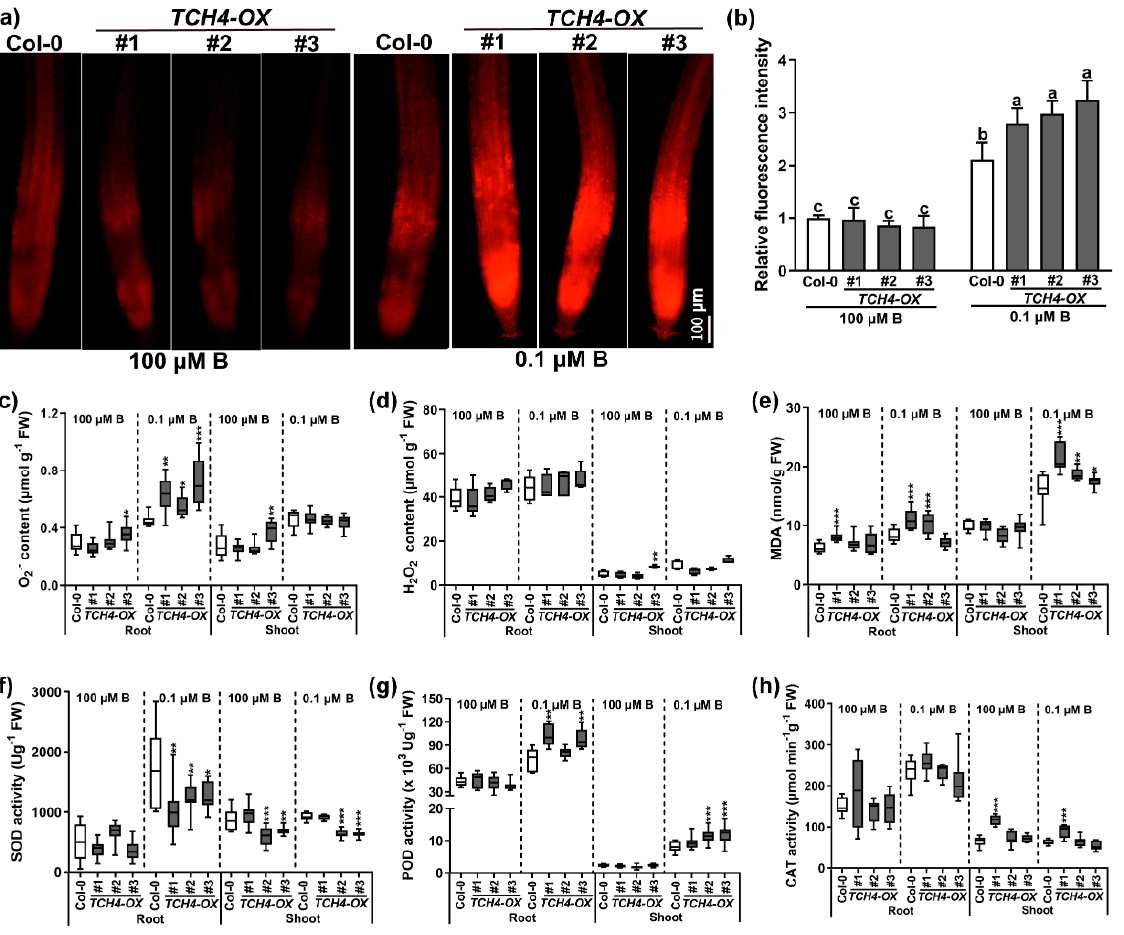
Figure 9. Differences in O 2 − , H 2 O 2 , and MDA content and antioxidant enzyme activities in Col-0 and TCH4-OX plants. The plants were grown in media consisting of 100 and 0.1 μ M B conditions for 10 d. ( a ) DHE staining. Scale bar, 100 μ m. ( b ) Relative fluorescence intensity was measured (means ± s.d., n = 7). The different letters above the columns indicate significant differences between all genotypes and all growth conditions ( p ≤ 0.05). ( c ) O 2 − , ( d ) H 2 O 2 , ( e ) MDA content, ( f ) SOD, ( g ) POD, and ( h ) CAT activity were determined (mean ± s.d., n = 6). The asterisks indicate statistically significant differences (* p < 0.05, ** p < 0.01, *** p < 0.001 according to a two-tailed unpaired Student’s t - test).